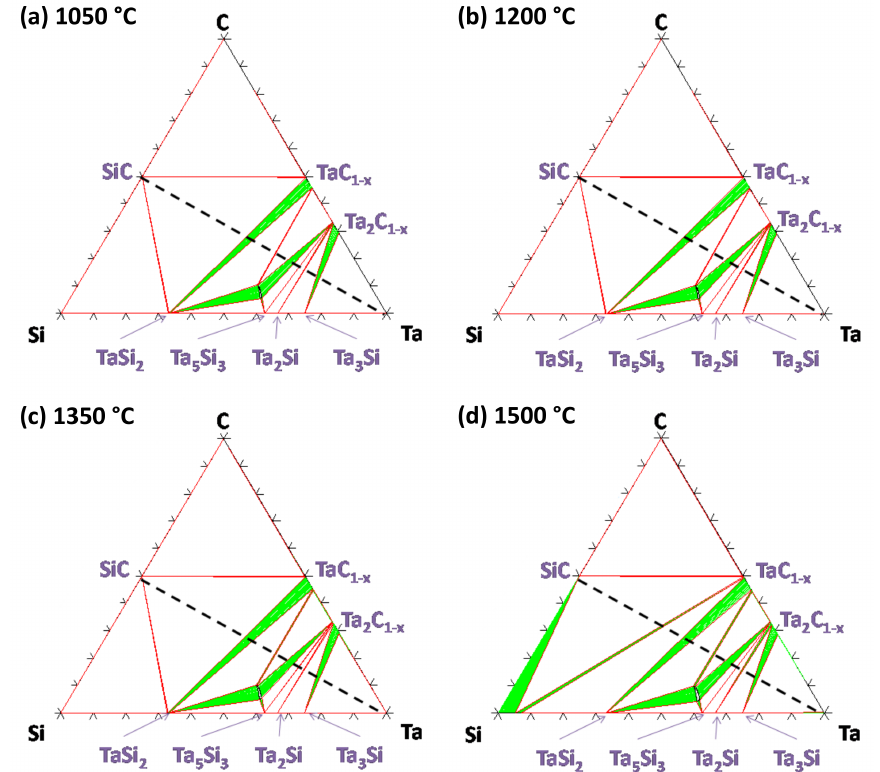
Figure 7. Isothermal sections of the ternary Ta–Si–C system calculated with Thermo-Calc software and the FUELBASE database at ( a ) 1050 ◦ C, ( b ) 1200 ◦ C, ( c ) 1350 ◦ C and ( d ) 1500 ◦